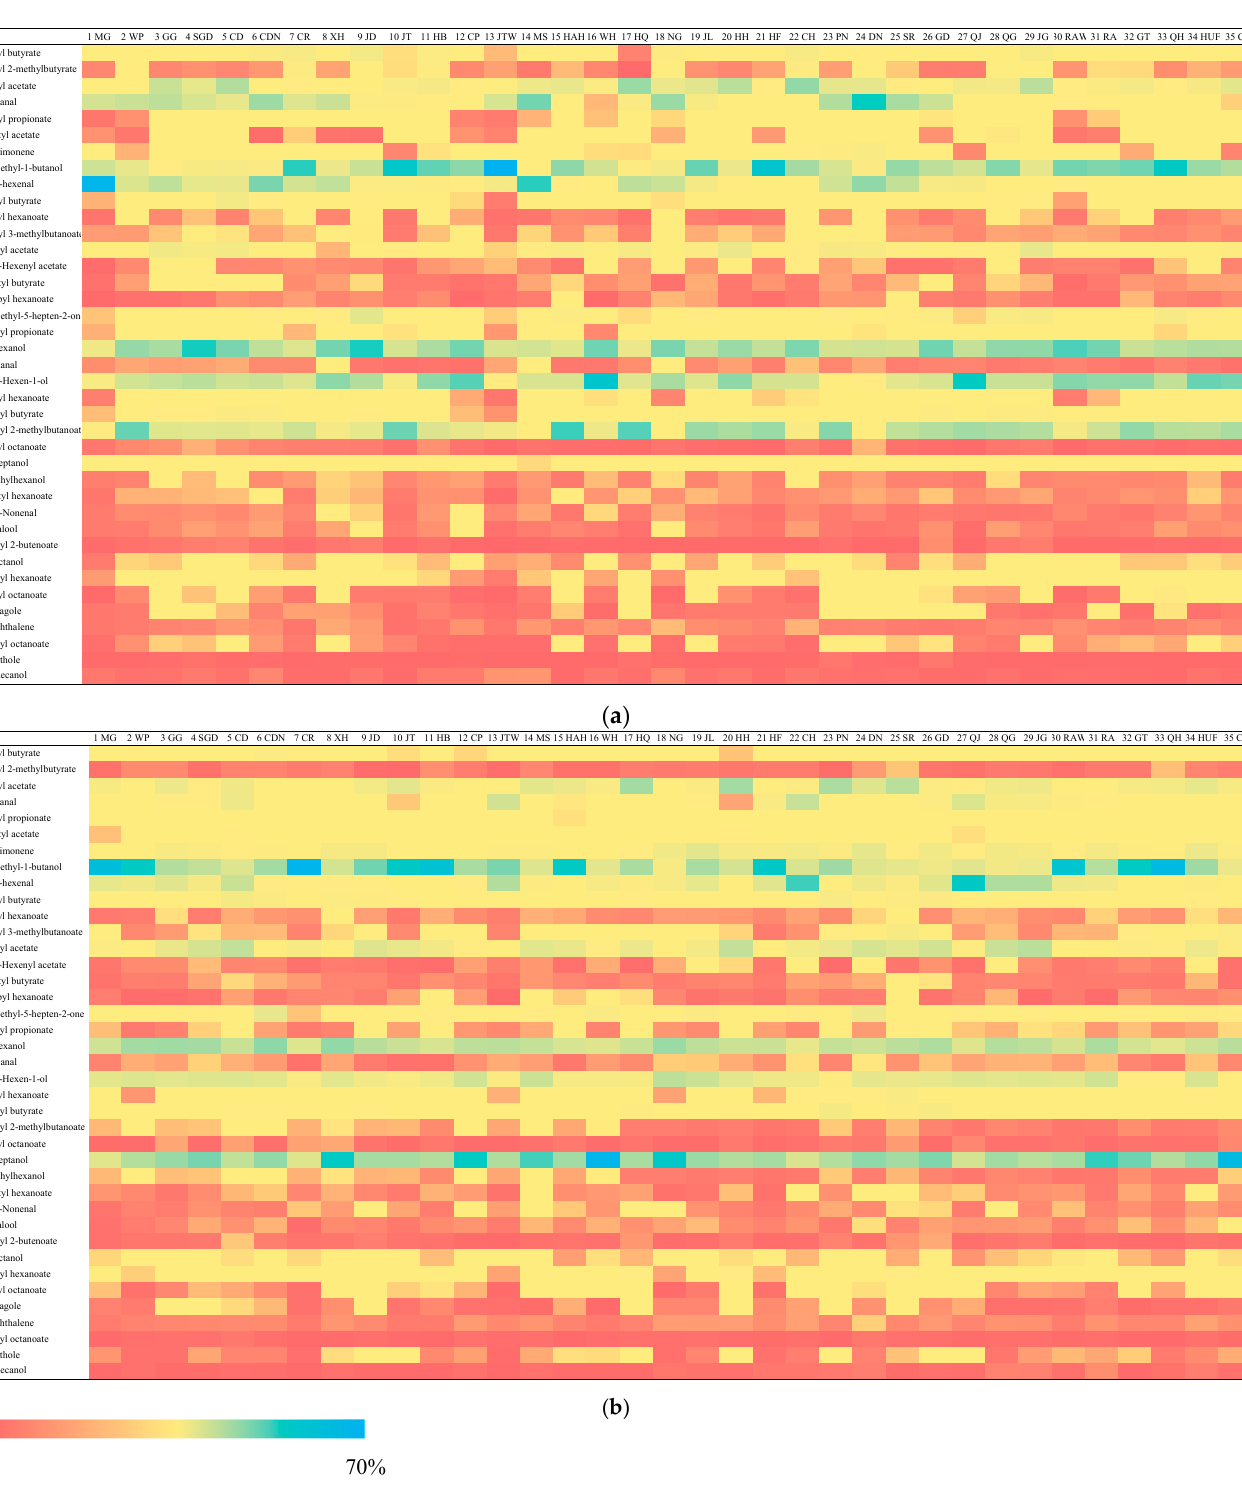
Figure 2. Heatmap displaying the percentages of 39 volatile compounds among 35 apple varieties in the first year ( a ) and the second year ( b ). The colors from red to blue represent the percentages from low to high for each variety. The apple cultivar abbreviation codes are MG-Miguo, WP-White Pippin, GG-Grimes Golsen, SGD-Stark Spur Golden Delicous, CD-Cloden, CDN-Cardinal, CR-Calville Rouge, XH-Xinhua, JD-Jonagold, JT-Jonathan, HB-Hadi Bolaite, CP-Clapp, JTW-Jonathan (New), MS-Mutsu Spur, HAH-Hahong, WH-Wenhong, HQ-Hongqiaowang, NG-Ningguan, JL-Judeline,